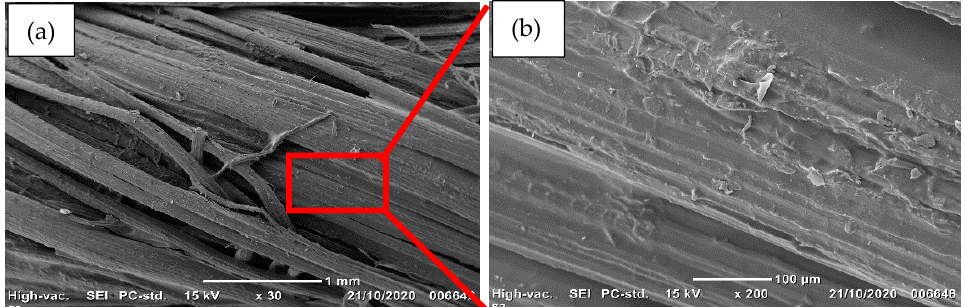
Figure 2. ( a ) SEM image of the surface of sisal yarn pre-coated with PVA. ( b ) Selected red lines area.